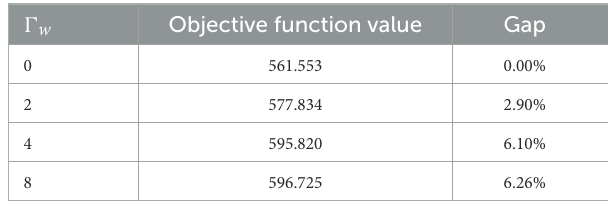
TABLE 4 Sensitivity analysis results of Ŵ w .